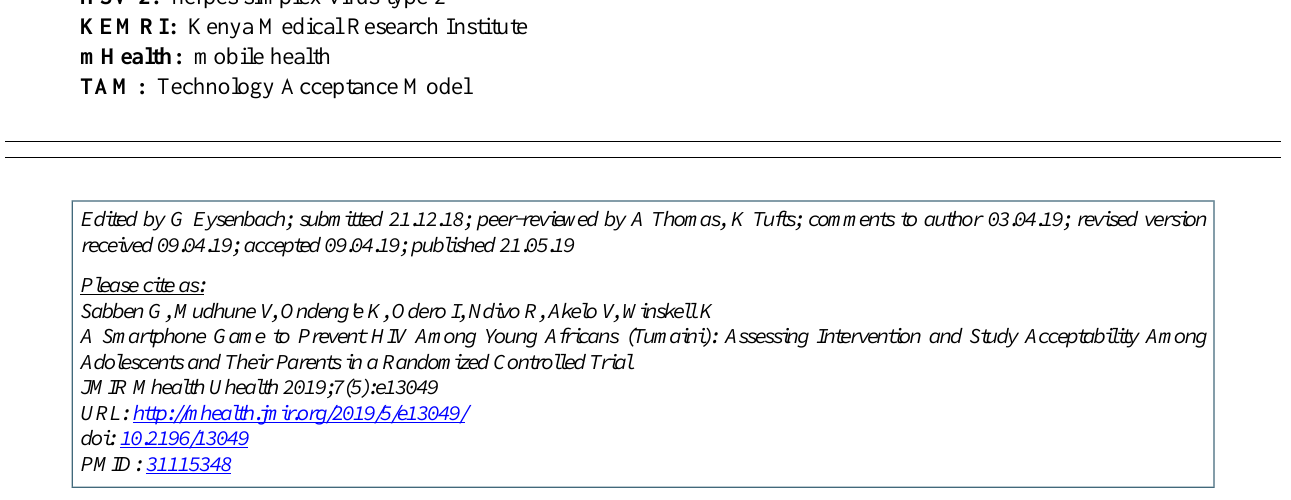
FGD: focus group